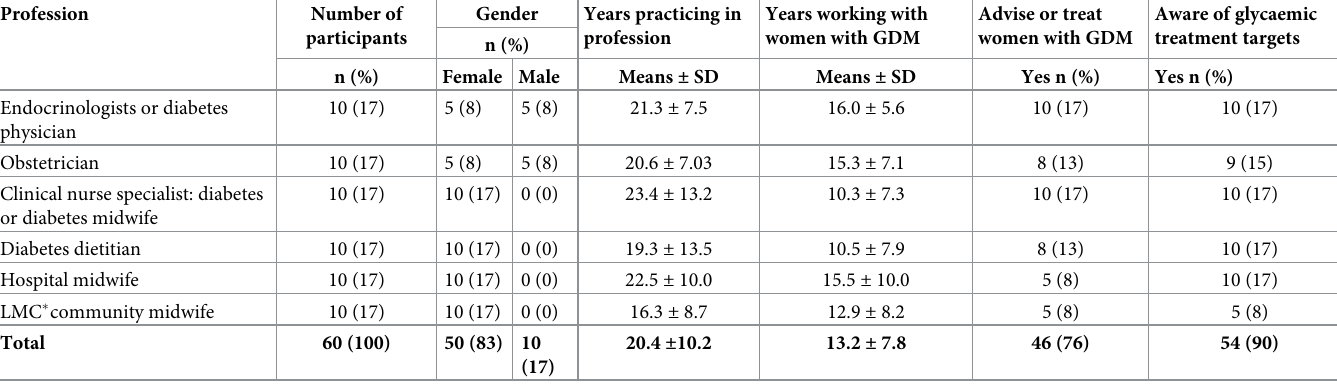
Table 1. Demographic characteristics of Key Informant Health Professionals surveyed across 10 hospitals (n = 60) # .